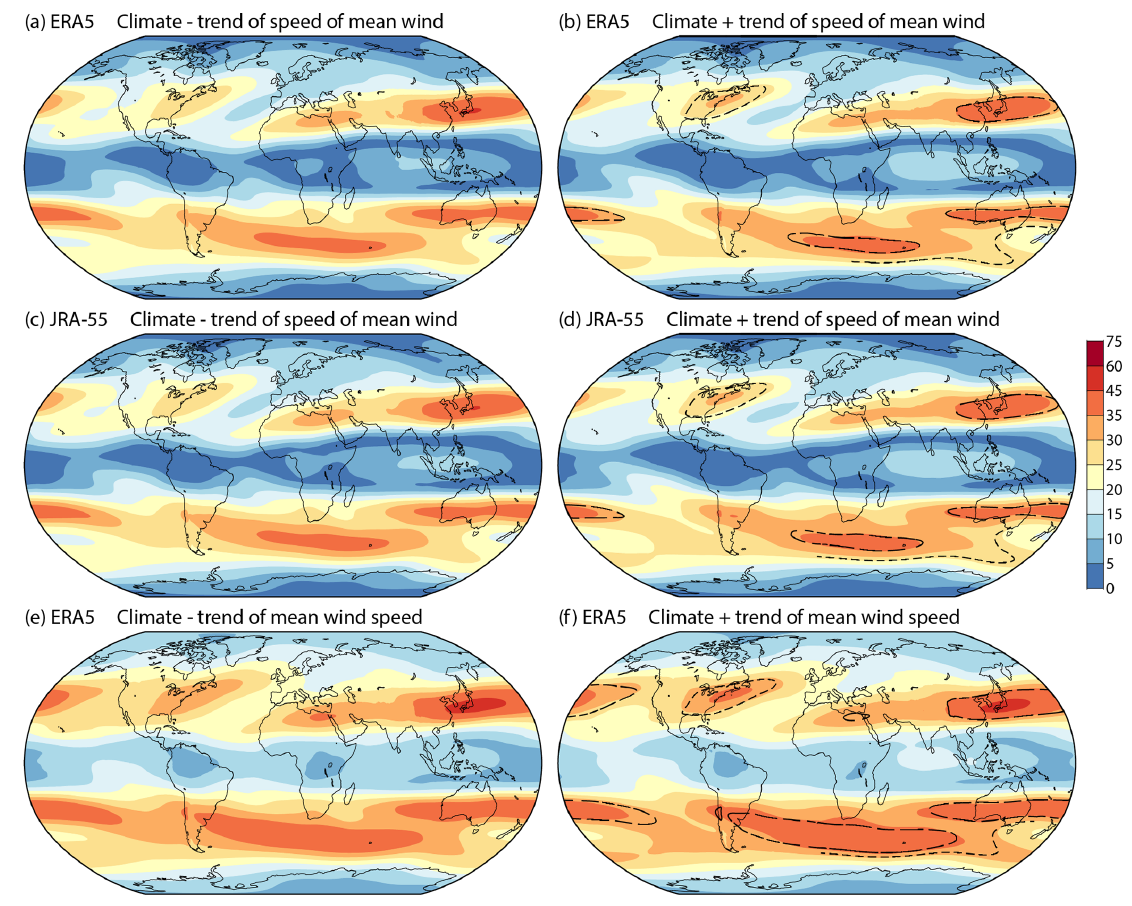
Figure 10. The 200hPa wind speeds (ms − 1 ) based on subtracting (left) and adding (right) the change over 21.5 years derived from least squares linear fits of monthly mean wind components from March 1979 to February 2022 to the average wind components for the period, shown for (a, b) ERA5 and (c, d) JRA-55. Panels (e) and (f) show corresponding ERA5 plots based on monthly means of hourly wind speeds. The longer dashed black contours in panels (b) , (d) and (f) show the 35ms − 1 contours from panels (a) , (c) and (e) respectively. Shorter dashed contours show transposed parts of the 25ms − 1 contours in panels (b) and (d) and of the 30ms − 1 contours in panel (f)